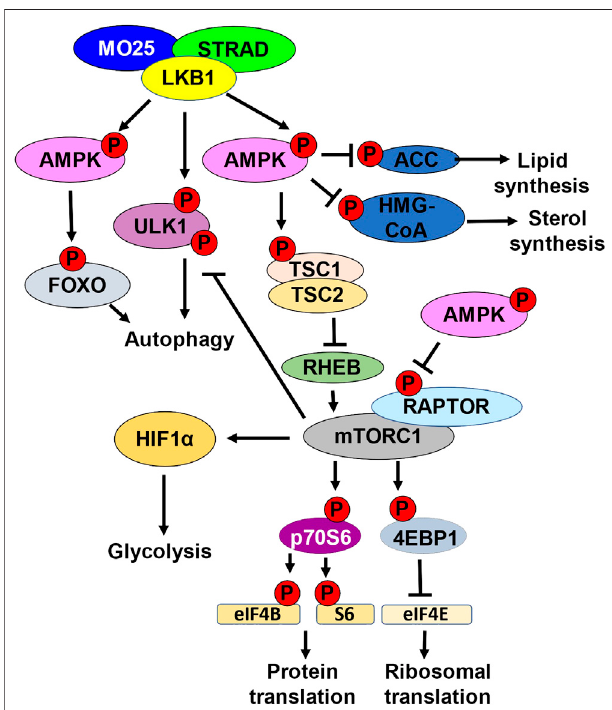
FIGURE 1 | LKB1 metabolic nexus. Schematic representation of downstream LKB1 signaling. LKB1 in complex with STRAD and MO25 phosphorylates and activates AMPK. AMPK phosphorylates and inhibits ACC, inhibiting lipid synthesis. AMPK phosphorylates and inhibits HMG-CoA, inhibiting sterol synthesis. Active AMPK also regulates autophagy by phosphorylatingandactivatingFOXO.LKB1candirectlypromoteautophagyby phosphorylating ULK1. LKB1 activation of AMPK also inhibits mTORC1 kinase activation. mTORC1 kinase phosphorylates and activates p70S6. p70S6 phosphorylates and activates eIF4B and S6 kinase, promoting protein translation. mTORC1 also phosphorylates and inhibits 4EBP1, the inhibitor of eIF4E. eIF4e activation leads to increased ribosomal translation. mTORC1 can also inhibits autophagy by phosphorylating ULK1. mTORC1 promotes glycolysis by upregulating HIF1 α . AMPK directly inhibits mTORC1 by phosphorylating RAPTOR. AMPK can also indirectly inhibit mTORC1 by phosphorylating and activating TSC1/TSC2. Active TSC1/2 complex inhibits RHEB.